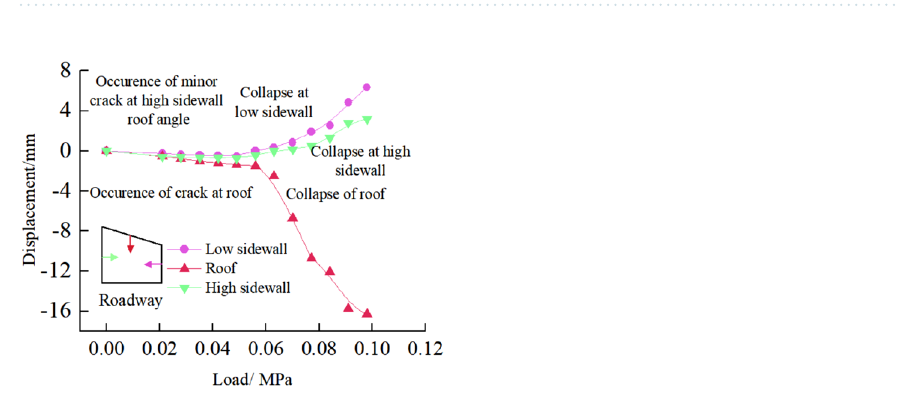
Figure 13. Variation of internal displacement of roadway with load.